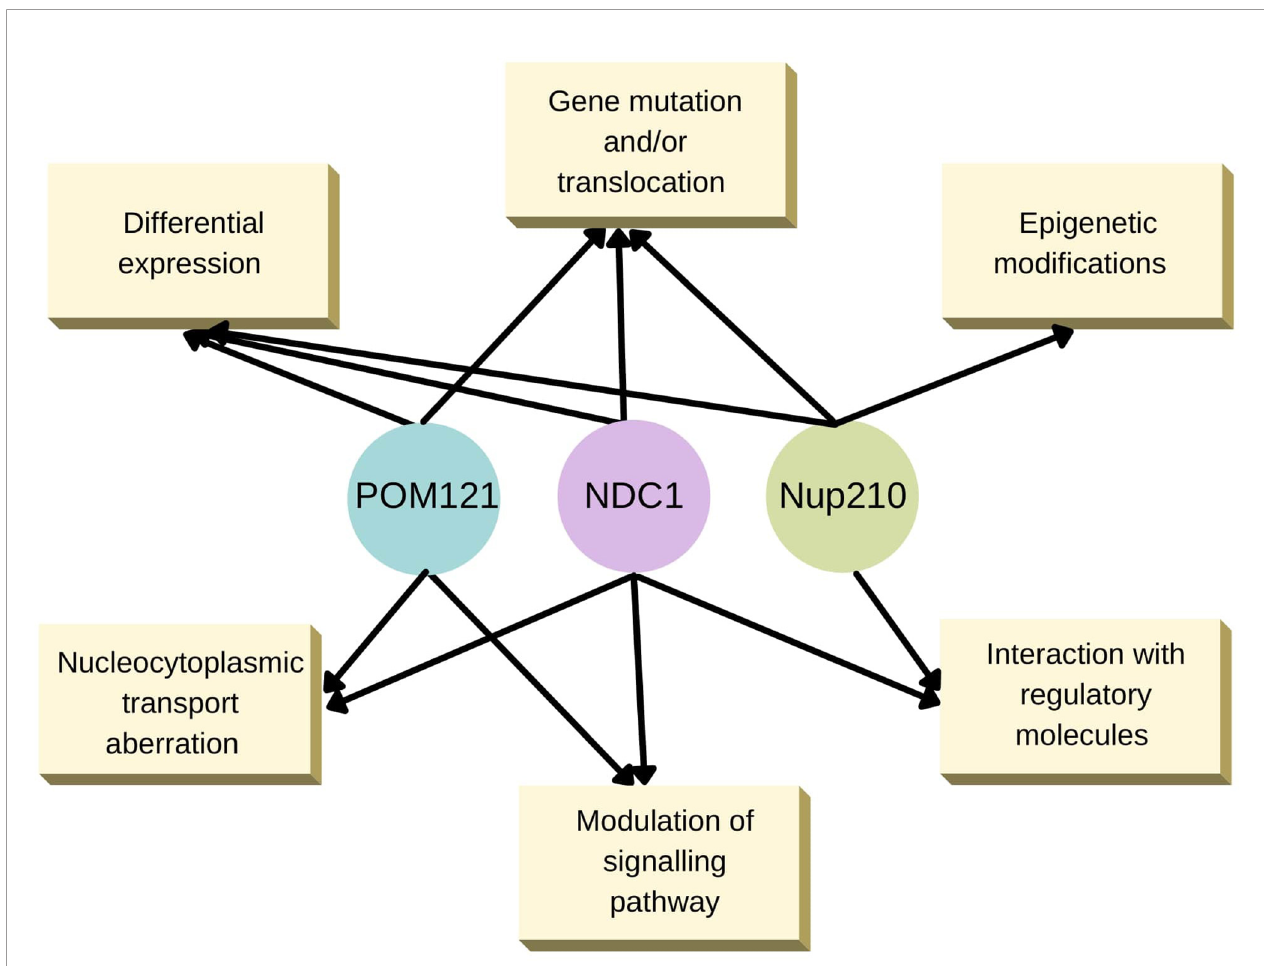
FIGURE 2 | Known transmembrane Nup alterations underlying human diseases. An interaction web of the three TM-Nups, POM121, NDC1 and Nup210 that regulate various cellular